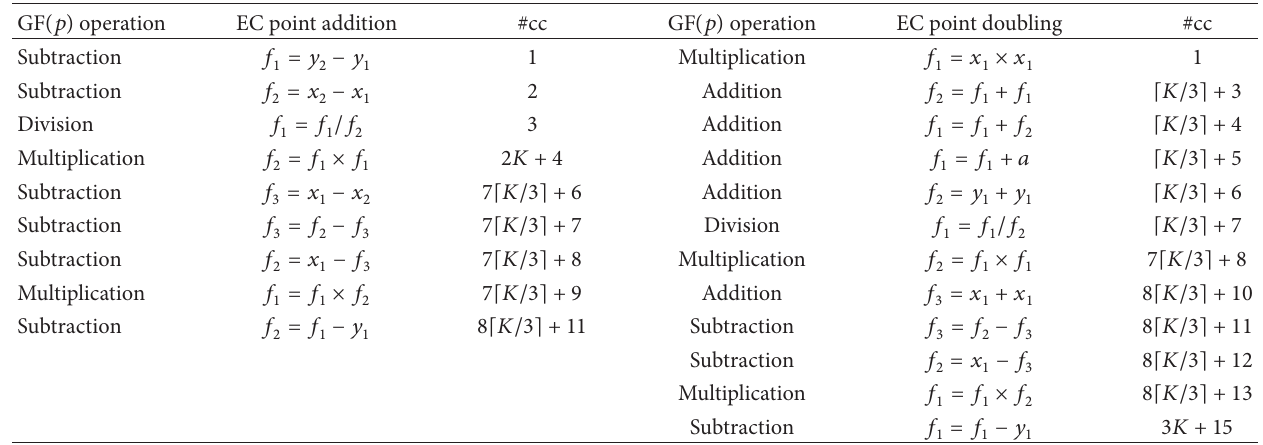
Figure 5: State diagram for main controller. Table 2: Sequences of GF (𝑝) operations for EC point